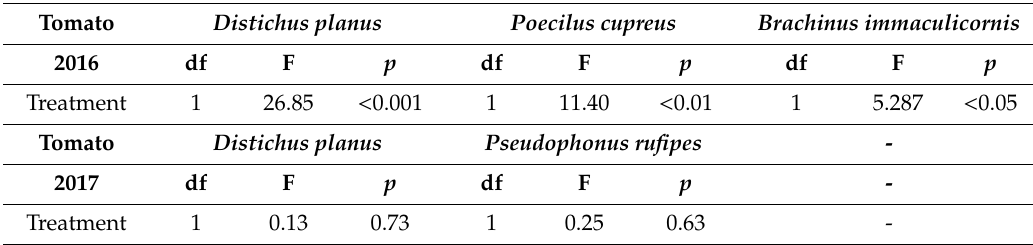
Tomato Distichus planus Pseudophonus rufipes